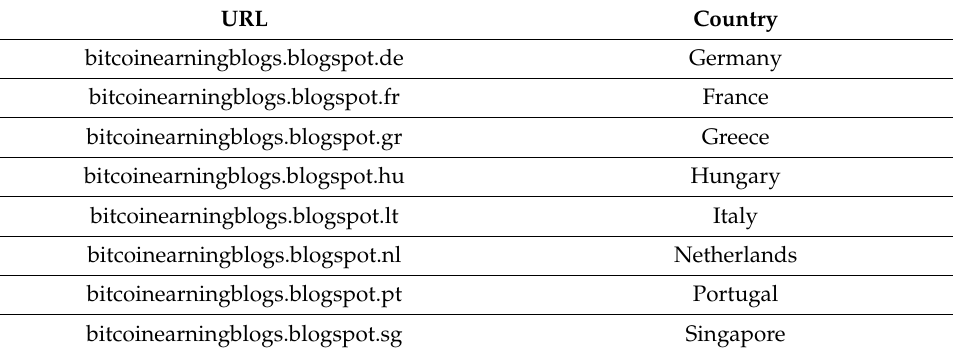
Table 3. Example of a web page with different domain names in different countries. URL Country